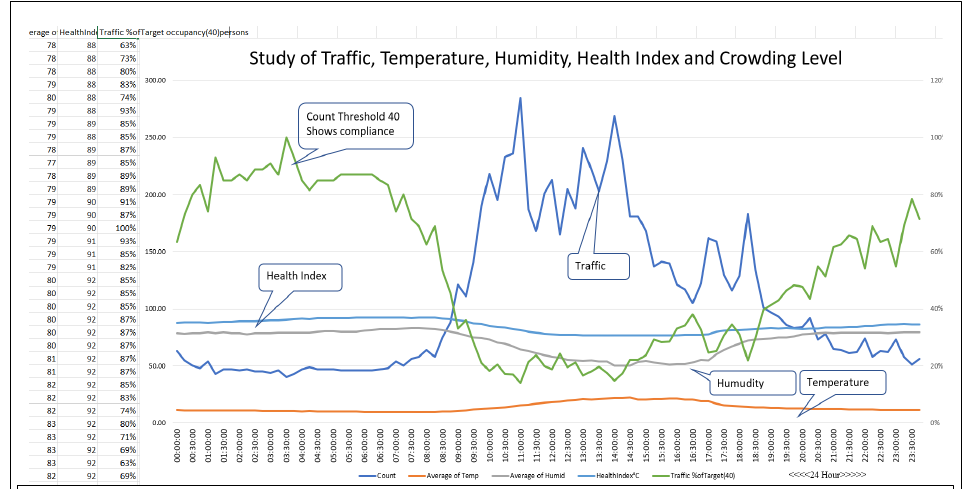
Figure 2. Related prior work building a city-wide IoT infrastructure for health and safety.